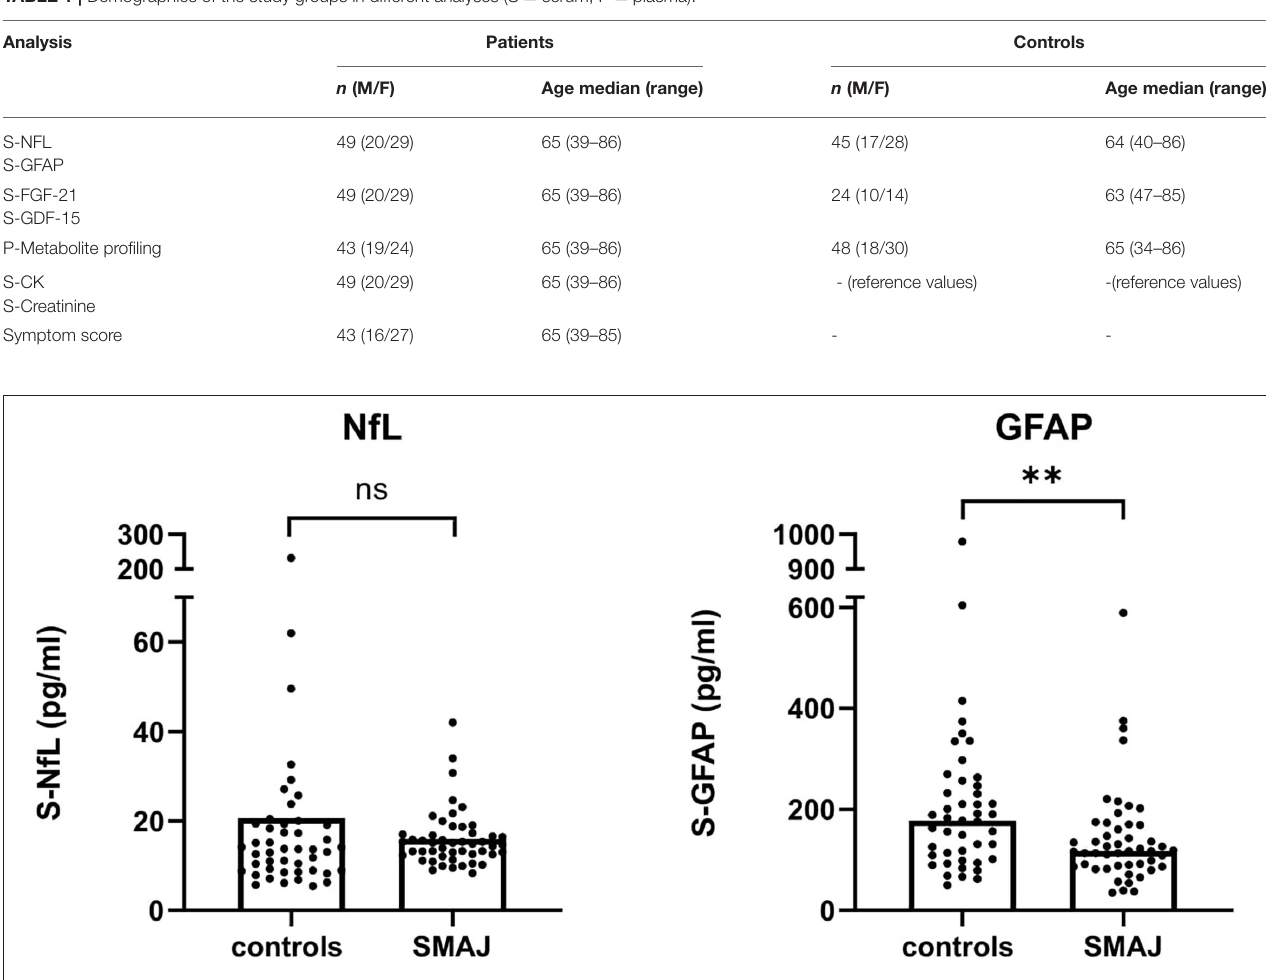
TABLE 1 | Demographics of the study groups in different analyses (S = serum, P = plasma). Analysis